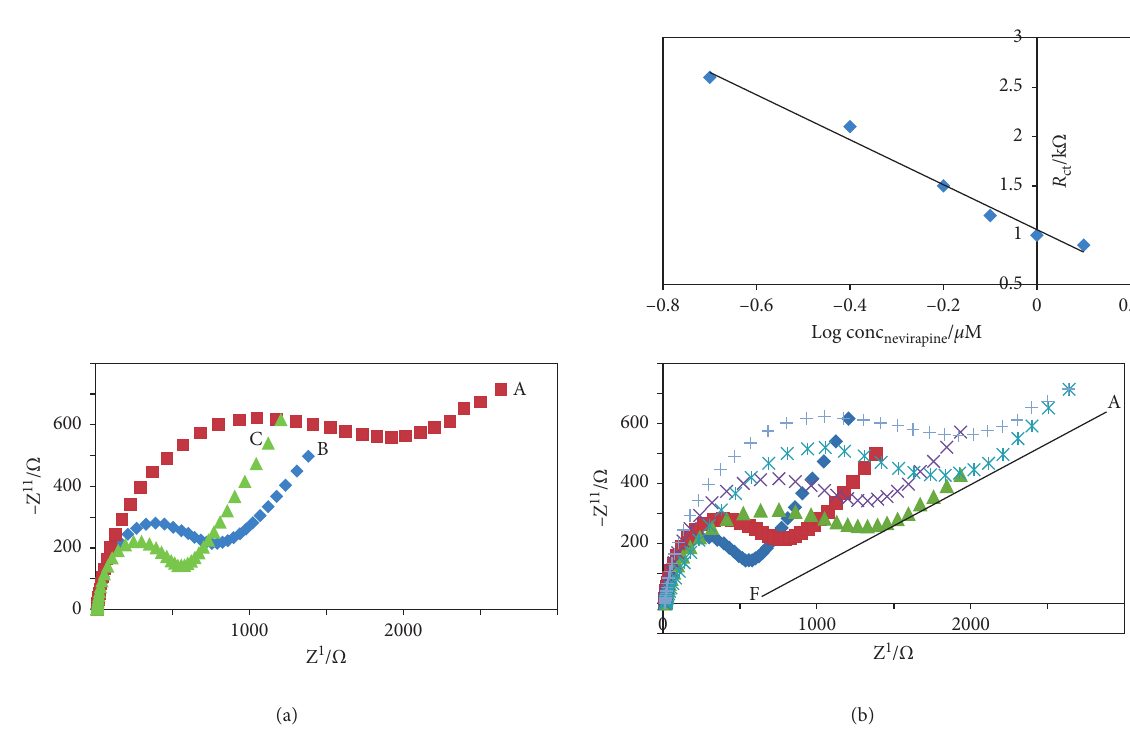
2 /GNR sensor with recently reported sensors.